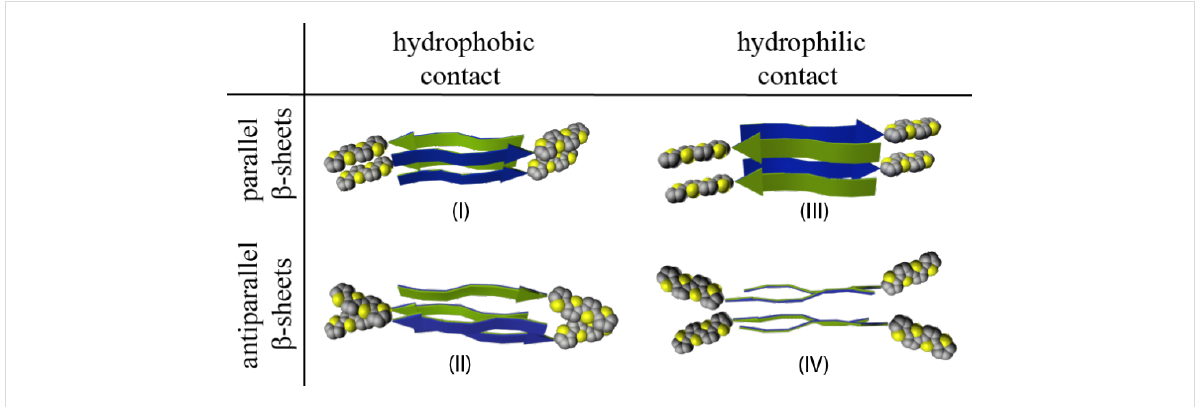
Figure 14: Schematic representations of constructed double-layer periodic arrangements from the hybrid molecule under study, classified by β -sheet orientation (parallel versus antiparallel) and the type of interlayer contact (hydrophobic versus hydrophilic) [23].